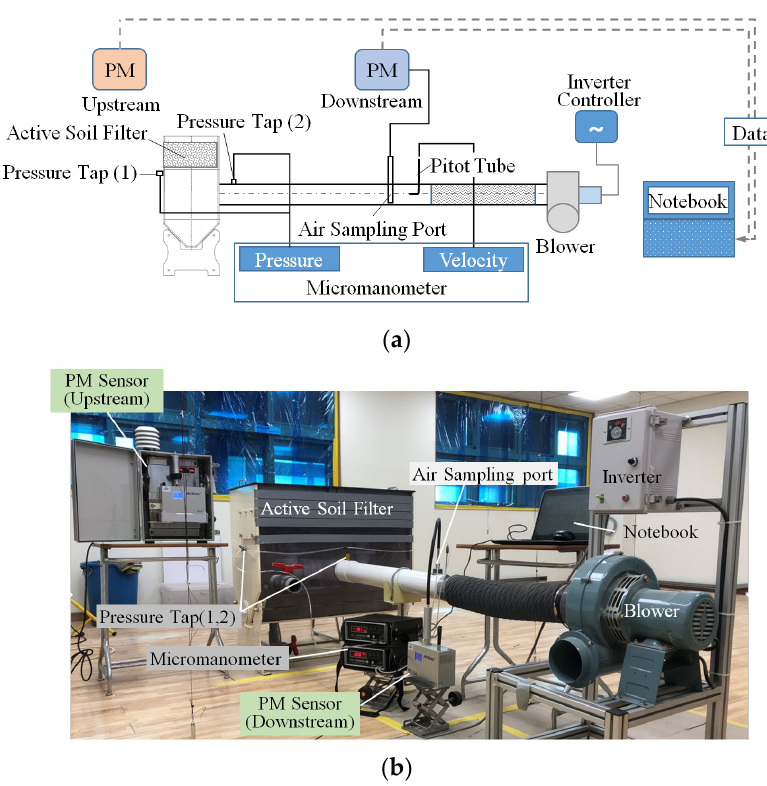
Figure 3. Experimental apparatus of the active soil filter system: ( a ) schematic view; ( b ) picture.